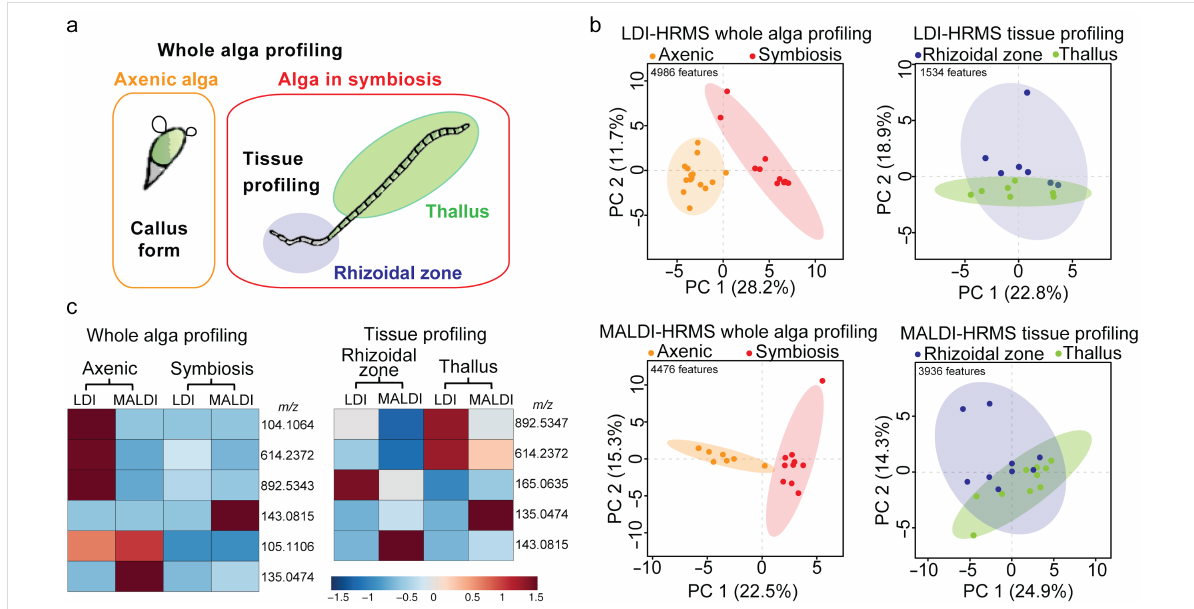
Figure 1: Untargeted comparative metabolomics using AP-SMALDI-HRMS highlighted metabolites involved in Ulva –bacteria symbiosis. a) The study looked at axenic algae with cell wall protrusions, the whole algae, and specific tissues with bacterial symbionts. b) The profiles of axenic alga (“axenic”) were contrasted with alga with bacterial symbionts (“symbiosis”) in the PCA score plots for LDI and MALDI-HRMS. The ellipses represent the 95% confidence region. c) The significant features ( m / z ) characterising axenic algae, algae in symbiosis, or differentiated tissues (blades/thalli, rhizoids) are represented in a heatmap with their relative abundance. The colour scale represents the averaged TIC normalised intensities per sam- ple class (red colour for high intensity, blue for low